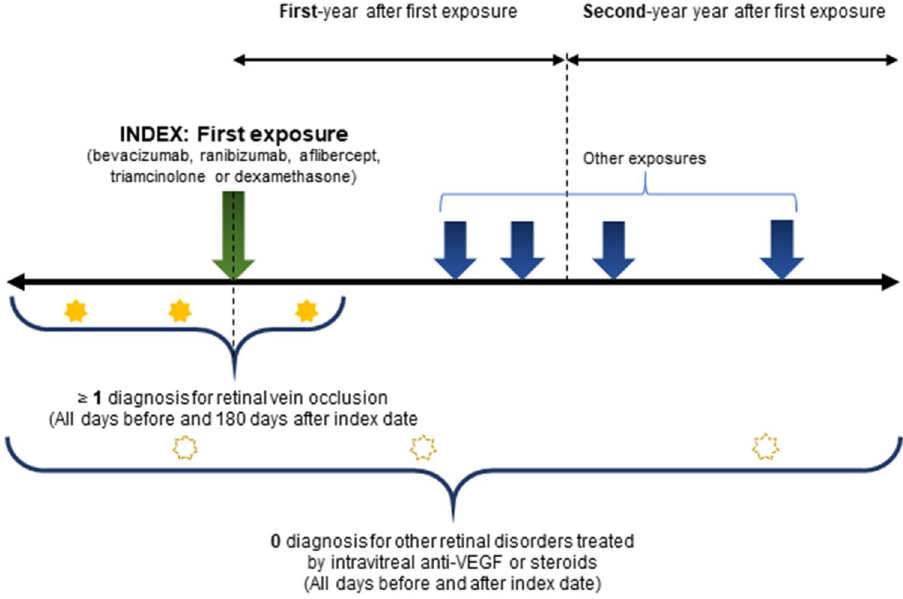
Figure 1. Schematic diagram for treatment pathways and intensities for macular edema following retinal vein occlusion. VEGF, vascular endothelial growth